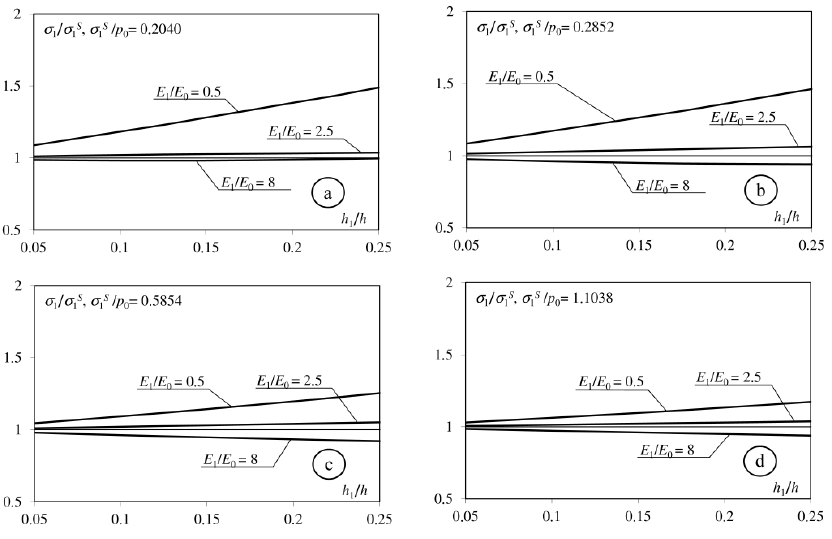
Figure 3. Dependence of the maximum tensile stress on the surface of the considered half-space on the h 1 / h parameters . ( a ): f = 0; ( b ): f = 0.1; ( c ): f = 0.25; ( d ): f = 0.5), h = 0.4; E 2 / E 0 = 4.